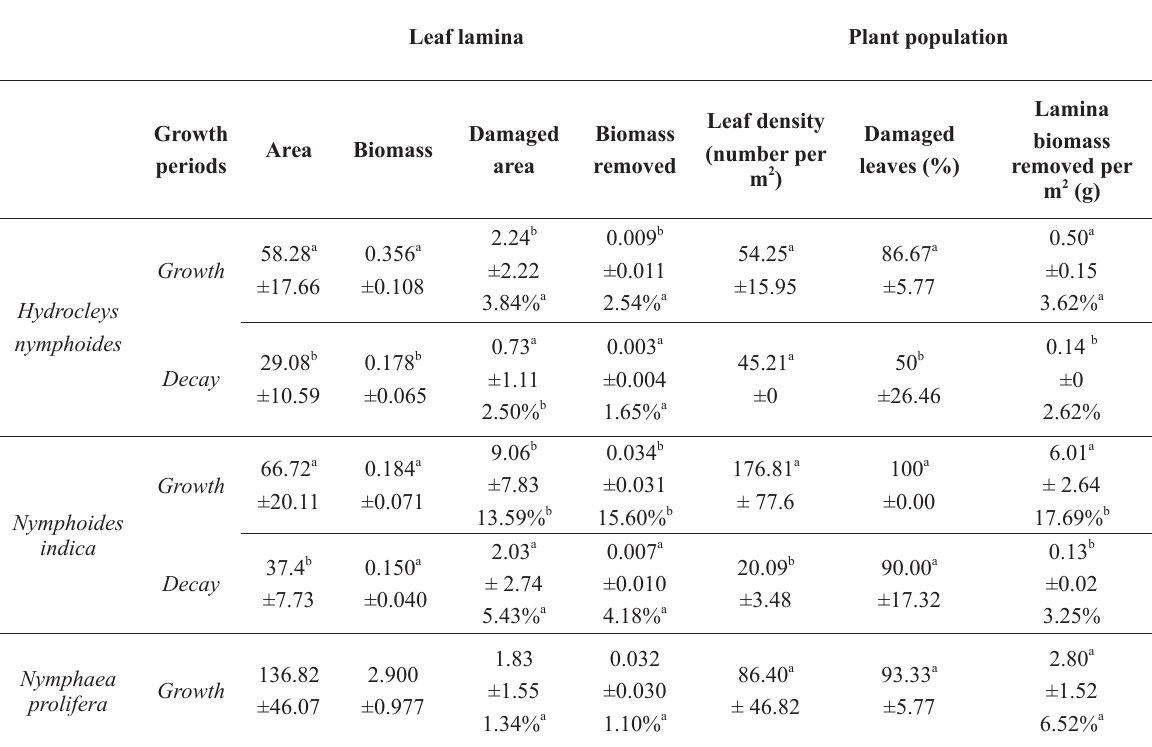
Area (cm 2 ) and biomass (g) of the leaf lamina and total damage (surface abrasions + holes) produced by invertebrate herbivores per lamina in leaves of Hydrocleys nymphoides and Nymphoides indica in growth and decay period, and Nymphaea prolifera in growth period. Values of herbivory are expressed as damaged area (cm 2 per lamina and per m 2 ) and biomass removed (g per lamina and per m 2 ): mean ± standard deviation. % removed per lamina. Different letters indicate means statistically different between sampling dates. Leaf lamina Plant